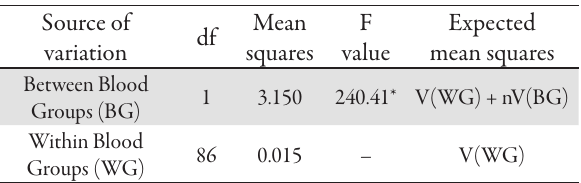
Tab. 2. Analysis of variance for allele frequency of Rh gene in